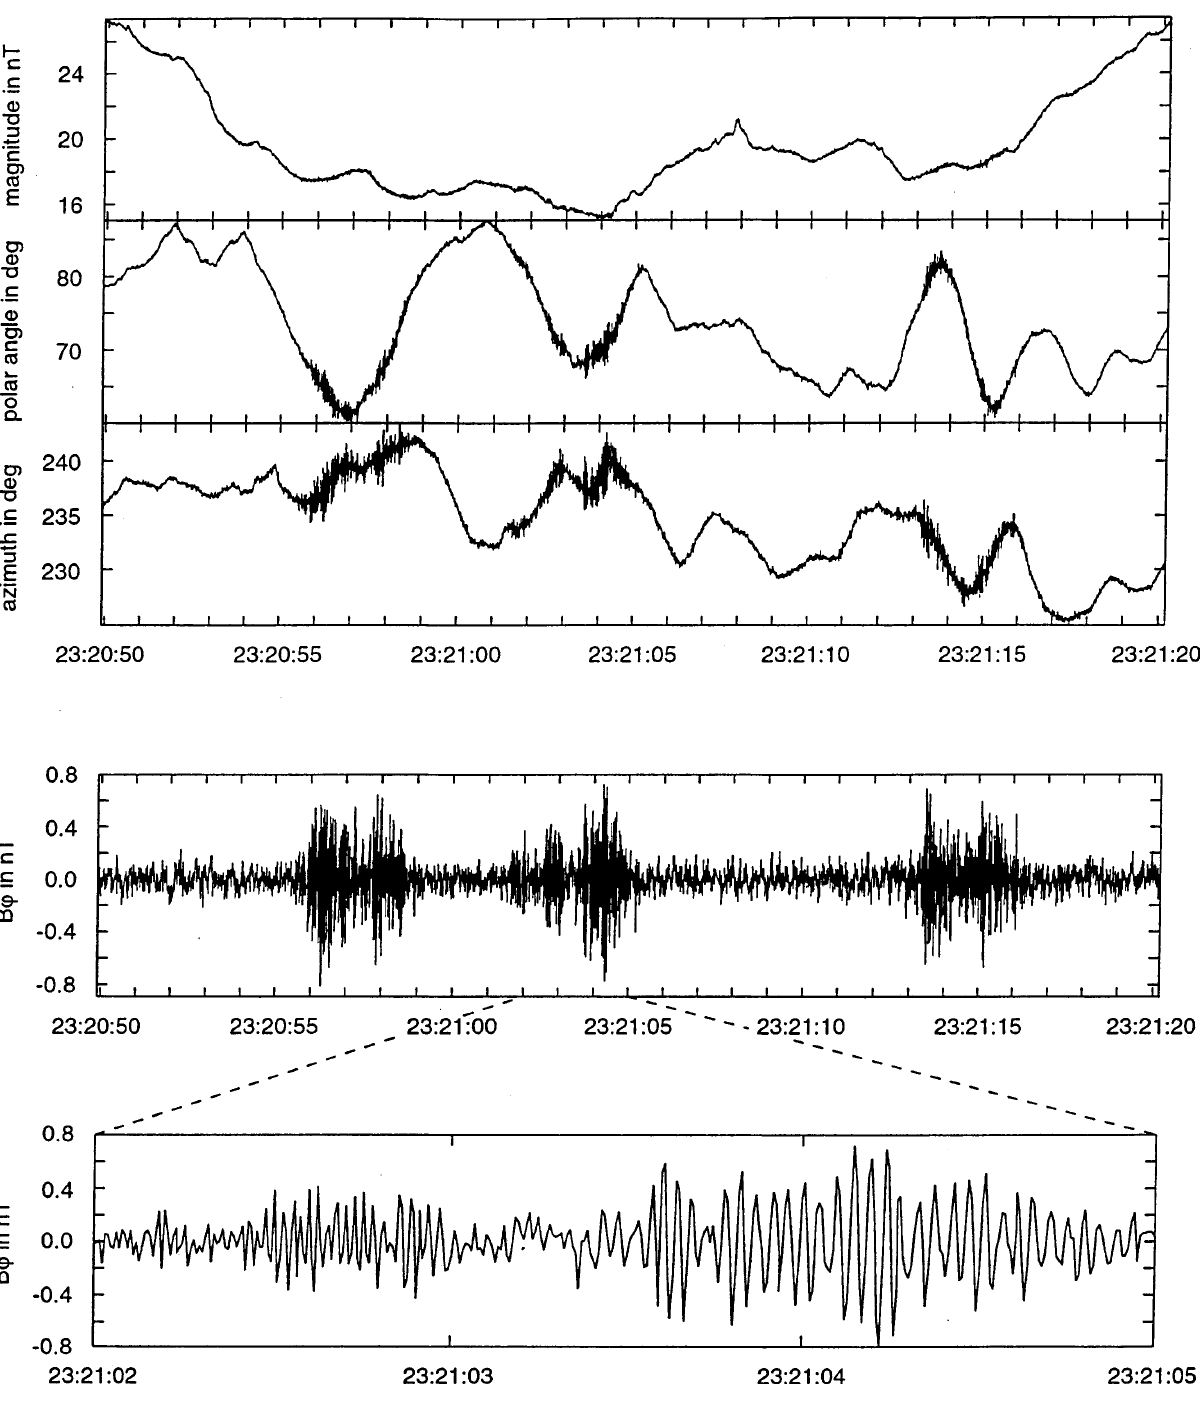
Fig. 7. Magnetic trough inside a magnetosheath mirror wave ( upper panel in GSE) and Lion Roar signal wave form perpendicular to the mean field ( lower panels